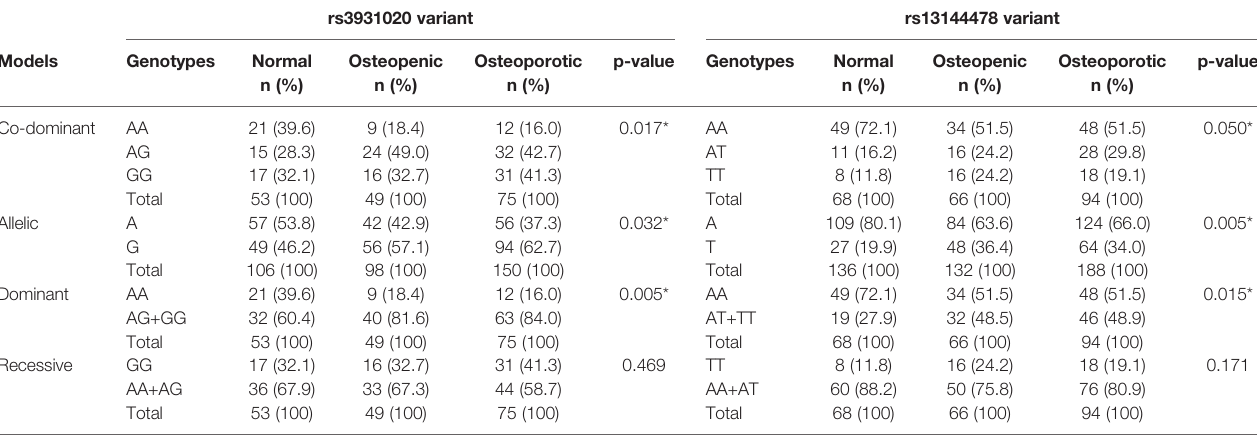
TABLE 2 | Comparison of rs3931020 and rs13144478 genotypic and allelic frequencies among the study